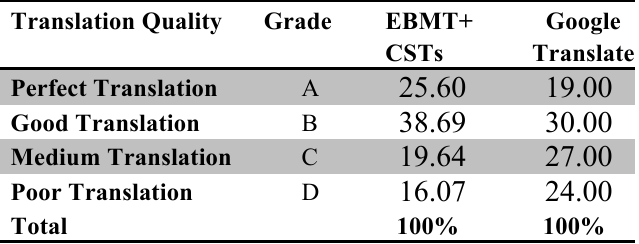
Table 8. Human Evaluation using same